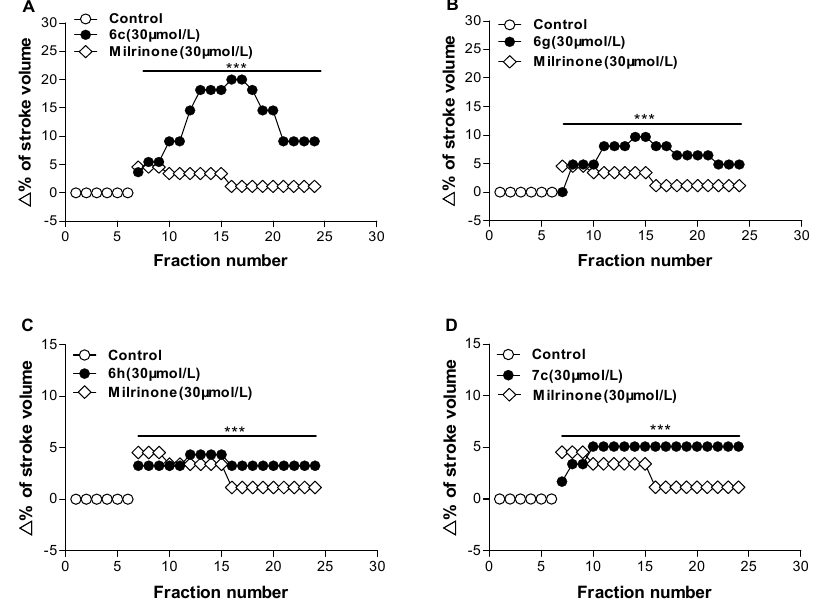
Figure 2. Effects of milrinone and compounds 6c , 6g , 6h , and 7c on stroke volume in beating rabbit atria (1.5 Hz). Values are means ± SE. *** p < 0.001 vs. control. ( A ): effects of compound 6c on stroke volume in beating rabbit atria, ( B ): effects of compound 6g on stroke volume in beating rabbit atria, ( C ): effects of compound 6h on stroke volume in beating rabbit atria, ( D ): effects of compound 7c on stroke volume in beating rabbit atria.